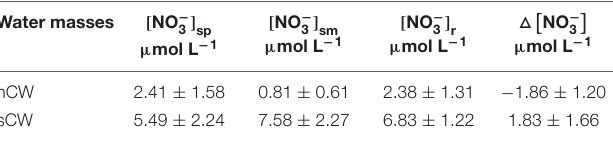
TABLE 3 | Comparison of regenerated [ NO − 3 ] (cid:3) in nCW and (cid:52) (cid:2) NO − 3